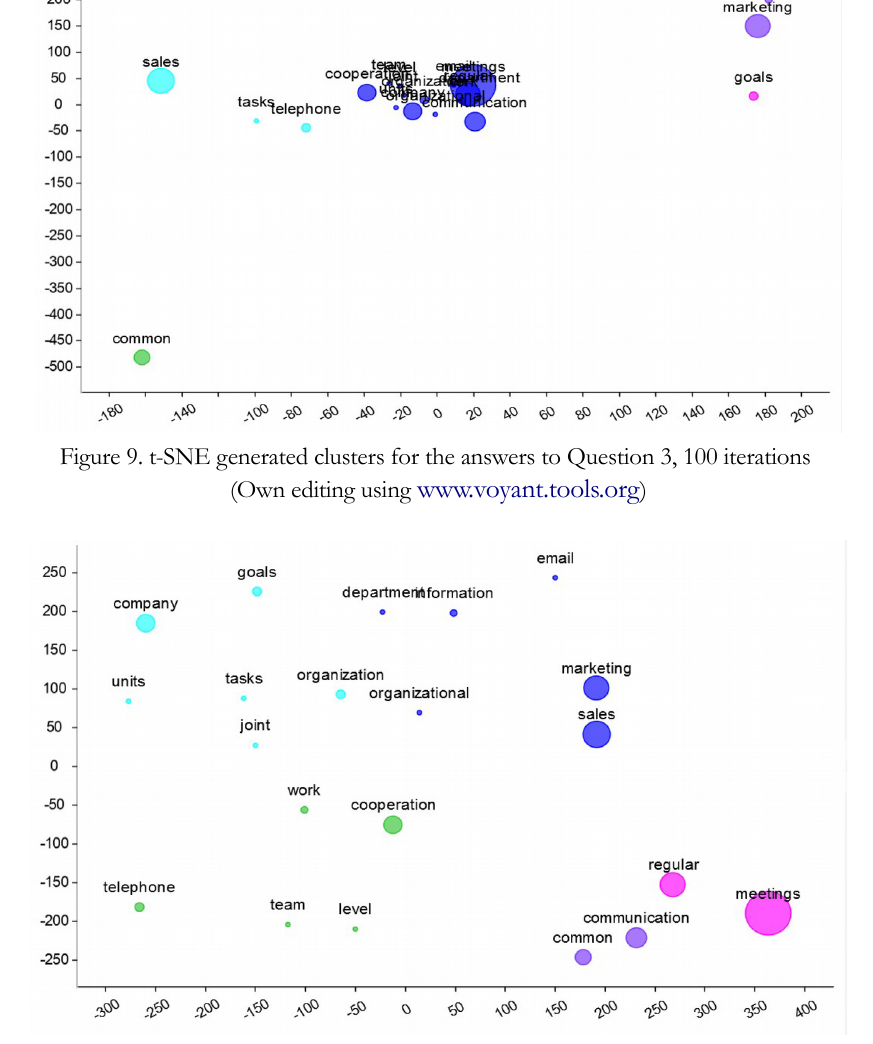
Figure 10. t-SNE generated clusters for the answers to Question 3, 600 iterations (Own editing using www.voyant.tools.org )